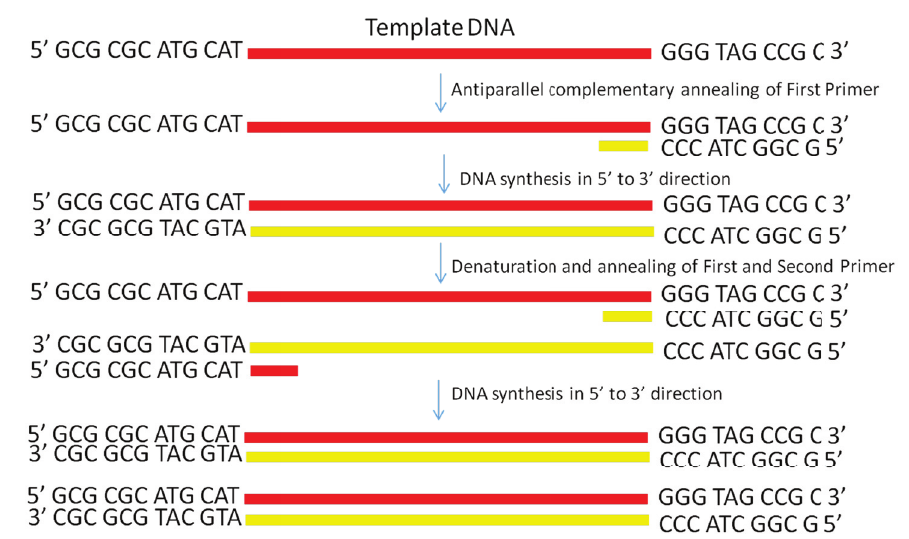
Figure 1. Schematic diagram showing PCR amplification of a single-stranded DNA by using conventional antiparallel oligonucleotide primers.